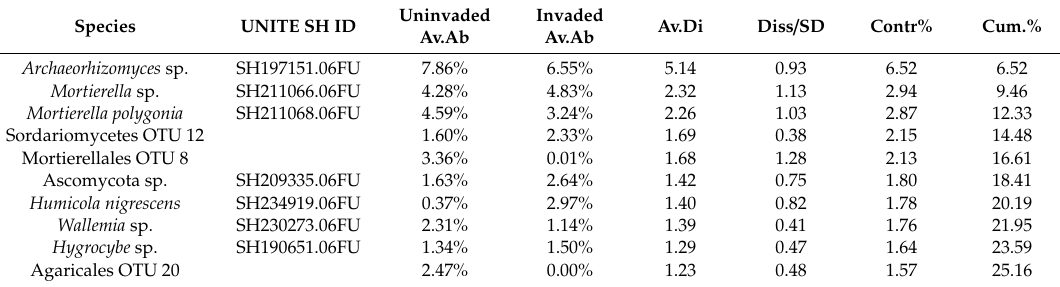
Figure 3. Class level di ff erences ( a ) in mean % relative abundances and ( b ) Venn diagram of assigned OTUs ( b ) between the two ( n = 25 each) sites. Table 3. SIMPER analysis for 10 species contributing most to the dissimilarity (25.16%) between the two sites ( n = 25 each). Av.Ab: average abundance; Av.Di: average dissimilarity; Diss / SD: dissimilarity / standard deviation; Contr%: contribution to the observed dissimilarity, % of total; Cum.%: cumulative contribution